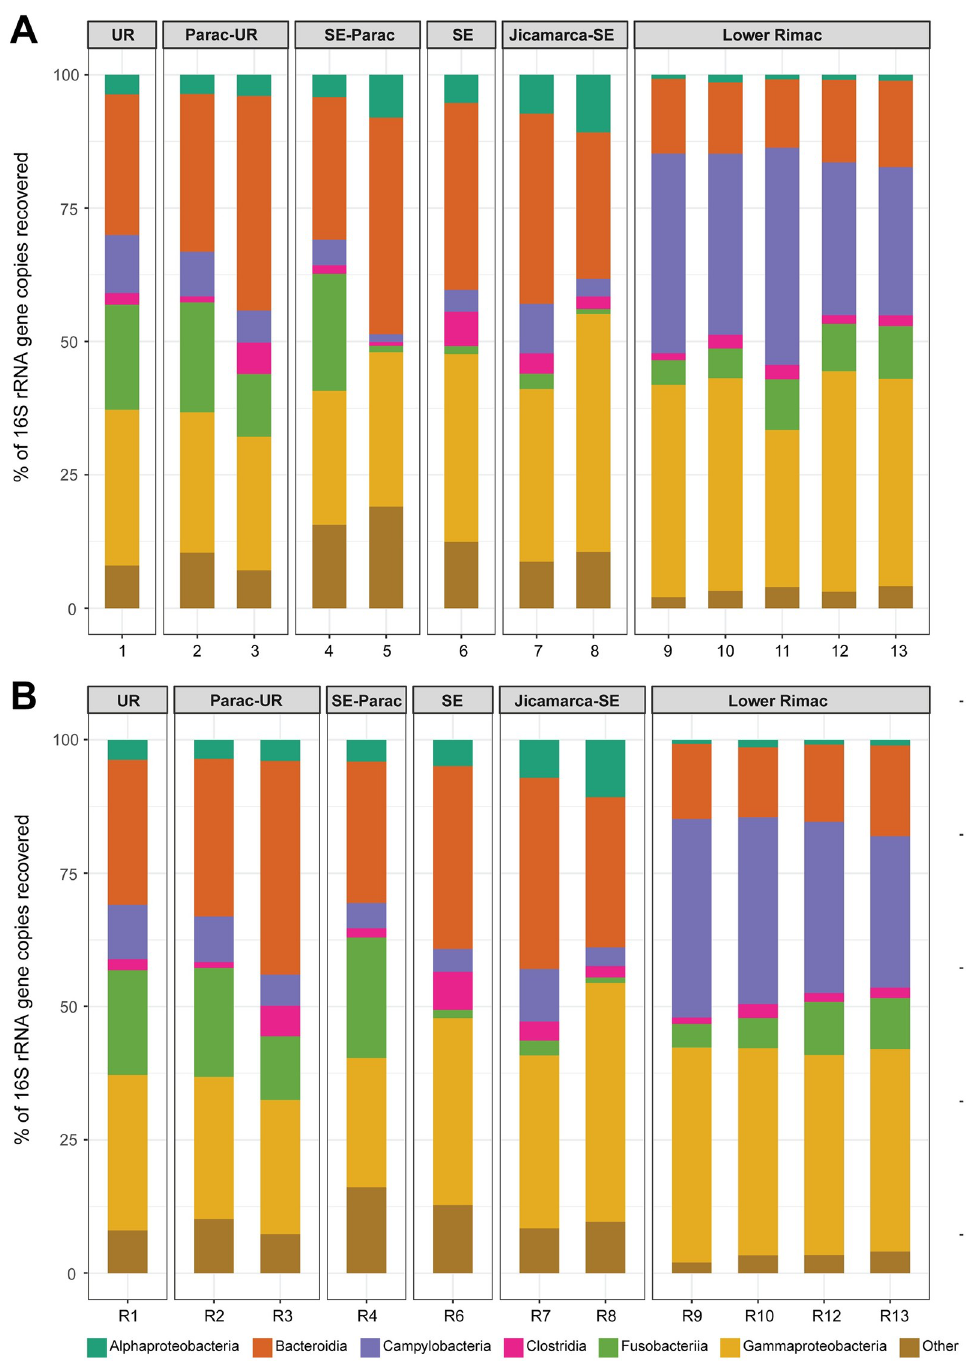
Fig 4. Stack barplot of the frequencies from the most common bacterial classes in each locality. Samples are numbered according to the information in Fig 1. UR: Upper Rimac, SE: Santa Eulalia. A. Samples, B. Replicates.